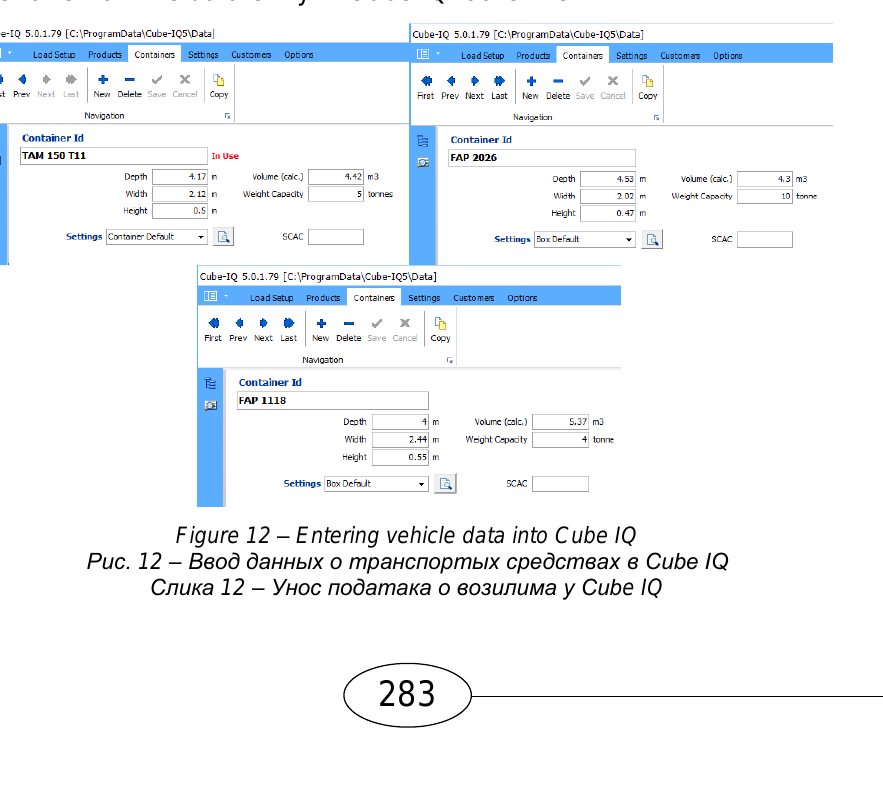
Figure 11 – Entry of goods input into Cube IQ Рис. 11 – Ввод товарных данных в Cube IQ Слика 11 – Унос улазних података о роби у Cube IQ